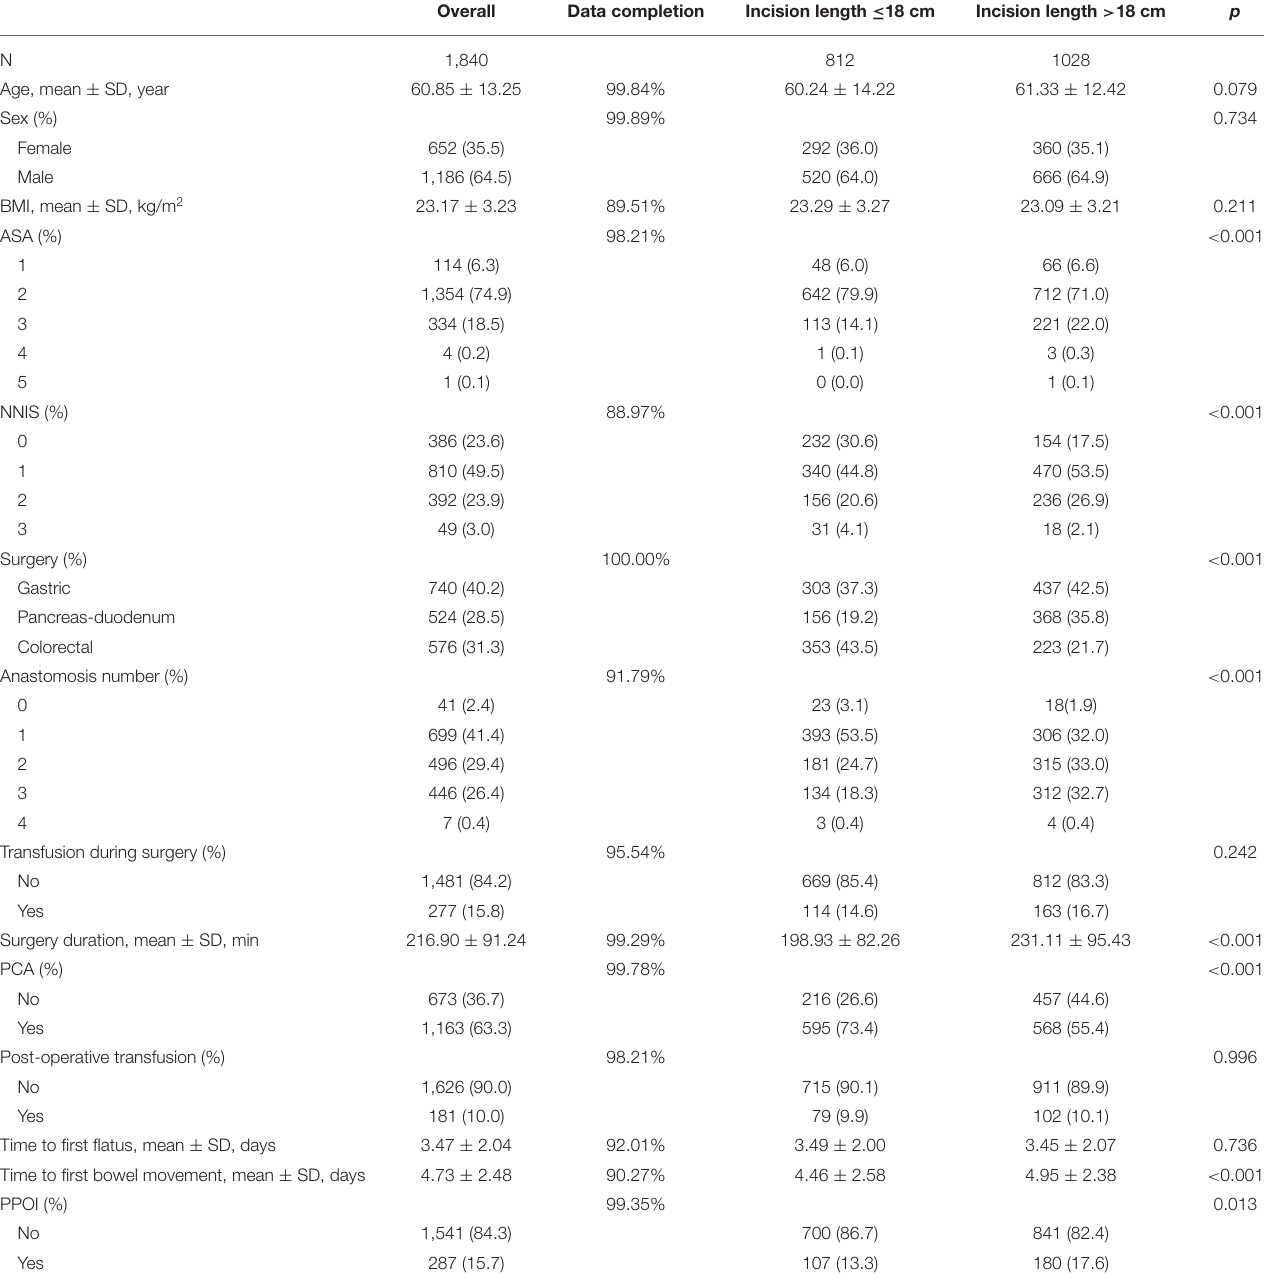
TABLE 1 | Baseline characteristics of the participants ( n =